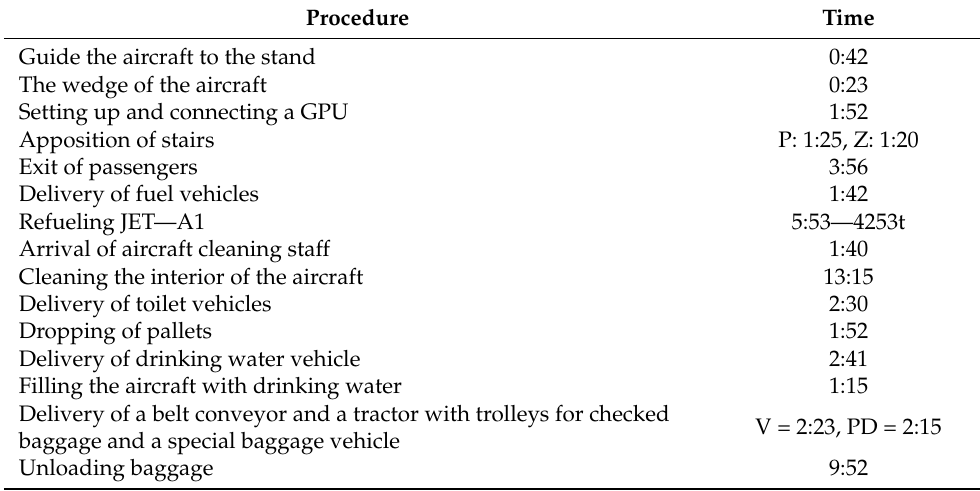
Table 3. Initial measurements of